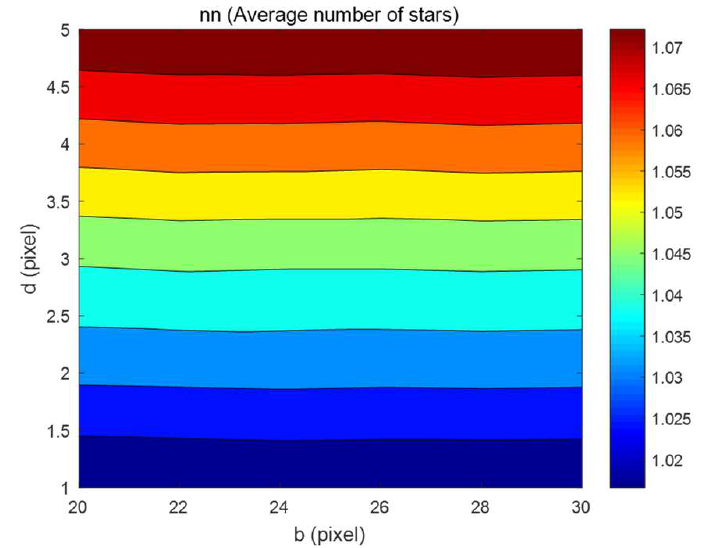
Figure 11. Average number of stars in the closest-neighbor star set nn under different radius thresholds b and different position tolerance scales d .